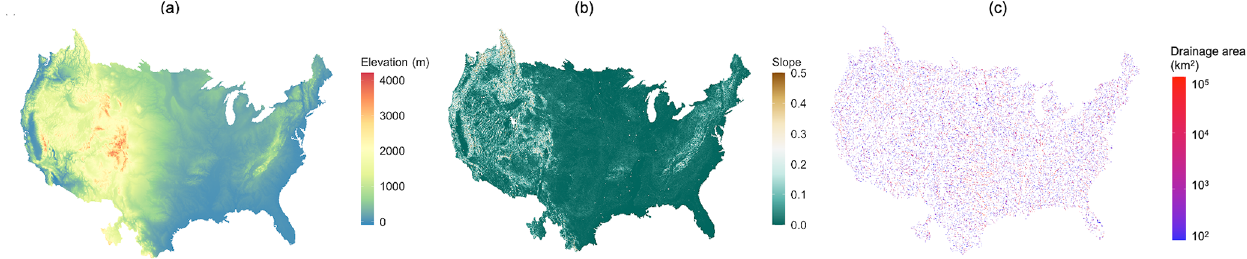
Figure 11. Demonstration of output datasets over CONUS: (a) processed DEM, (b) slope and (c) drainage area. Table 2. Summary of gridded outputs included in the